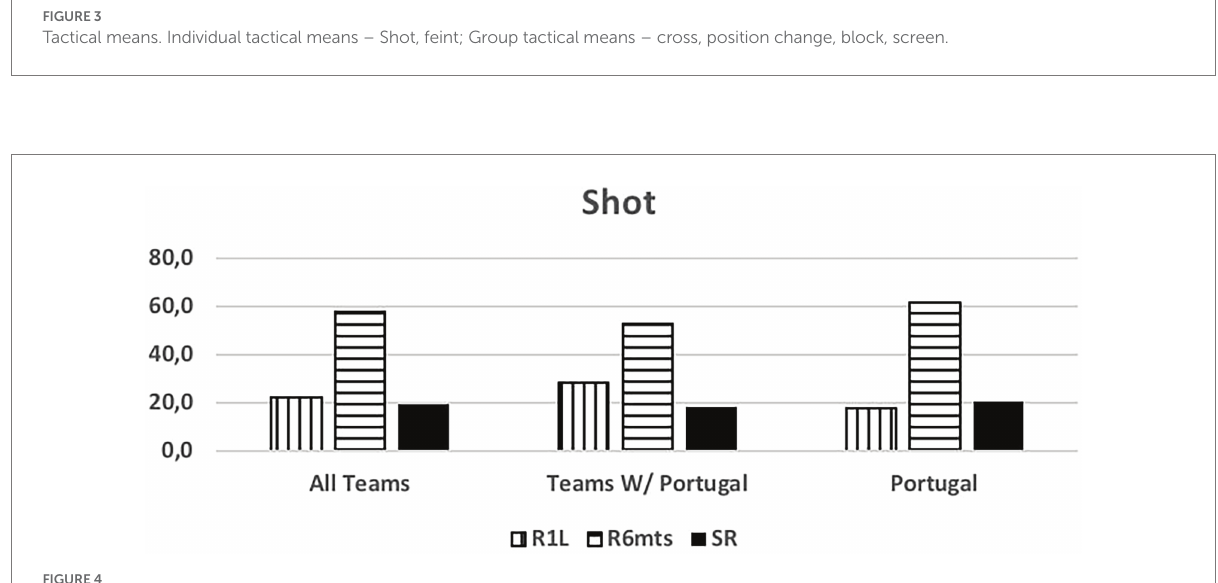
Figure 7 approaches the “Opponent Team Response Result.”